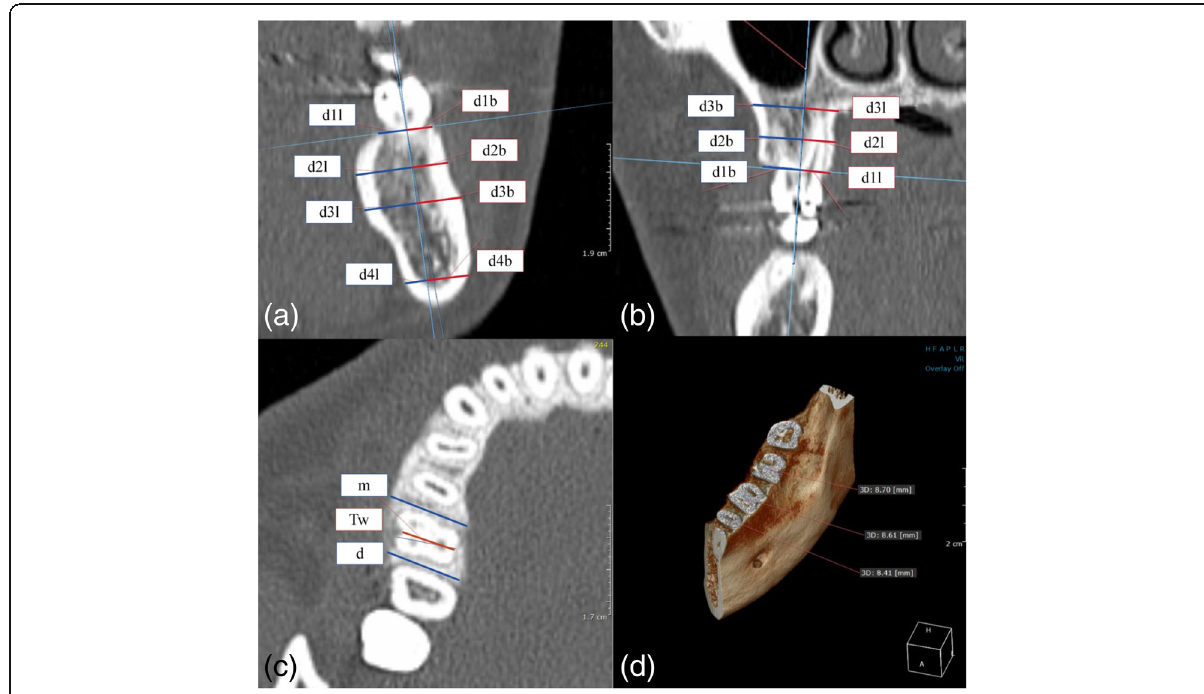
Fig. 2 Measurement of horizontal width of alveolar bone. a Working on a coronal view of the mandibular first molars. b Working on a coronal view of the maxillary first molars. c Measurement of the horizontal width of the interdental alveolar bone crest (m, d) and the teeth (Tw). d Working on volumetric view on mandibular first molars. d1 = bone width at the crestal level; d2 = bone width at the mid- root level; d3 = bone width at root the apex level; d4 = bone width at the mandibular border level. b, l = buccal and lingual sides; m, d = mesial and distal sides; Tw = width of tooth at the alveolar bone crest